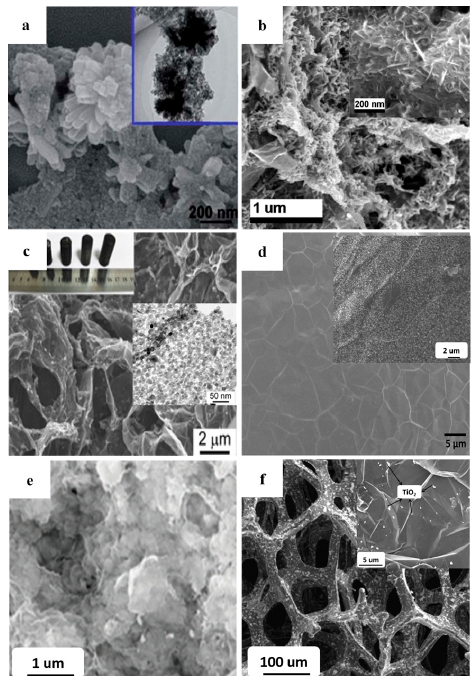
Figure 12. The 3D graphene-TiO 2 composite photocatalysts with various morphologies of